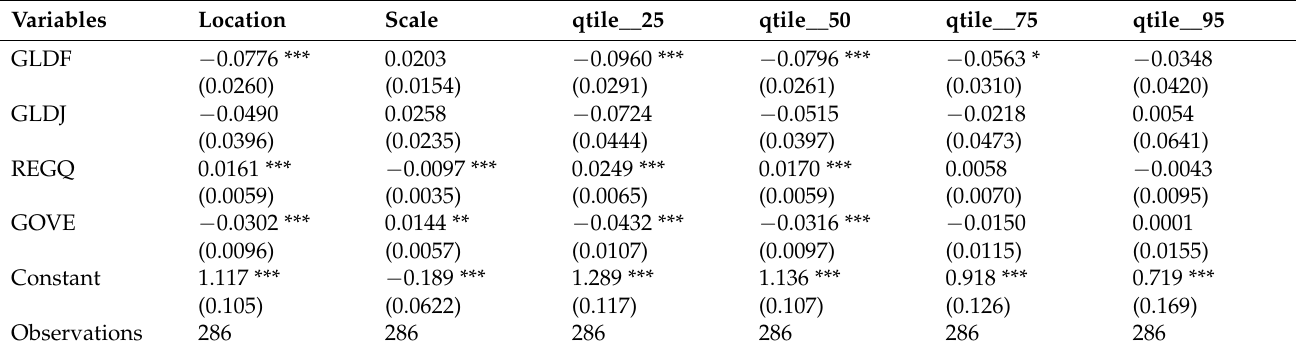
Table 3. Model 1. DV: Income Inequality Gini Coefficient (INGN).